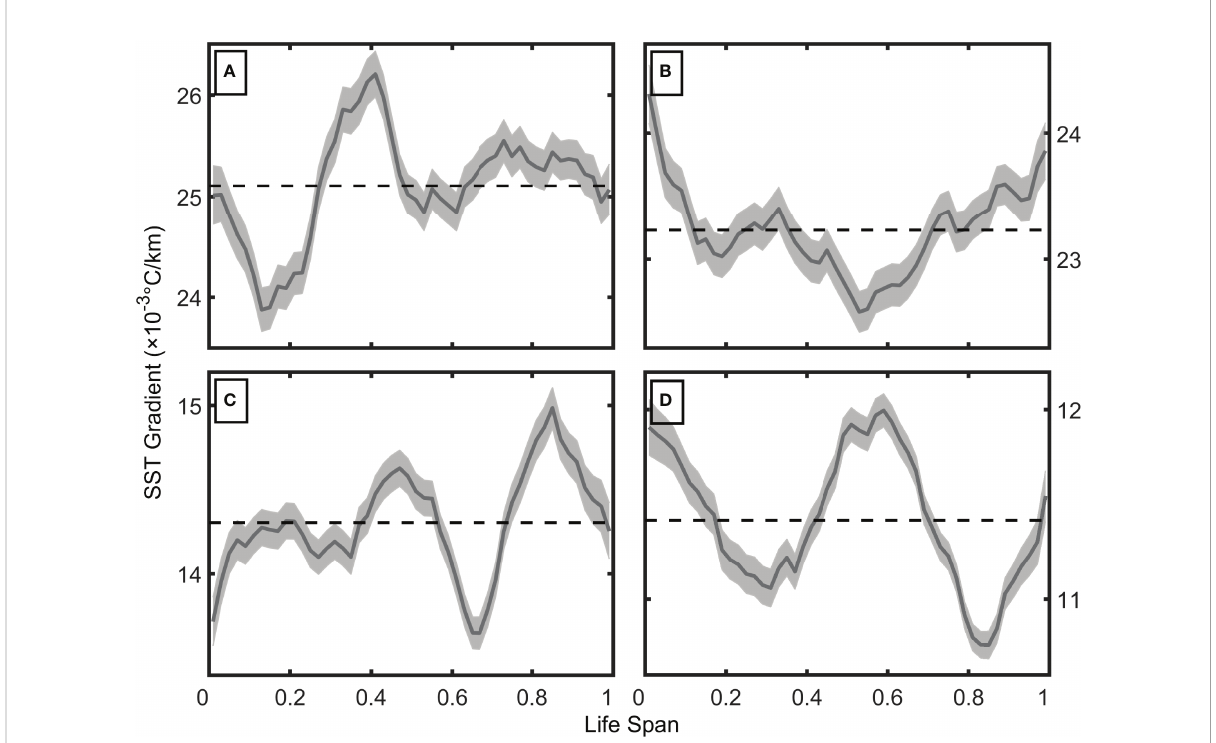
FIGURE 4 Temporal evolutions of the averaged SST gradient (×10 -3 °C/km) for (A) an anticyclone and (B) a cyclone in the north and (C) an anticyclone and (D) a cyclone in the south over the lifetimes of the eddies. The dashed horizontal line represents the corresponding overall average. The gray shading represents standard